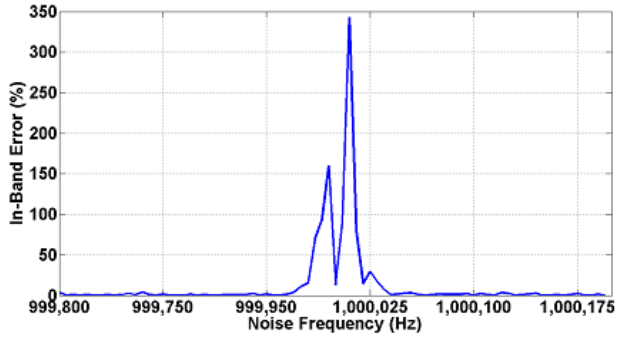
Figure 13. Amplitude recovery for the test signal of 10 mV rms at the maximum operating frequency limit of 1 MHz buried in −20 dB of sinusoidal